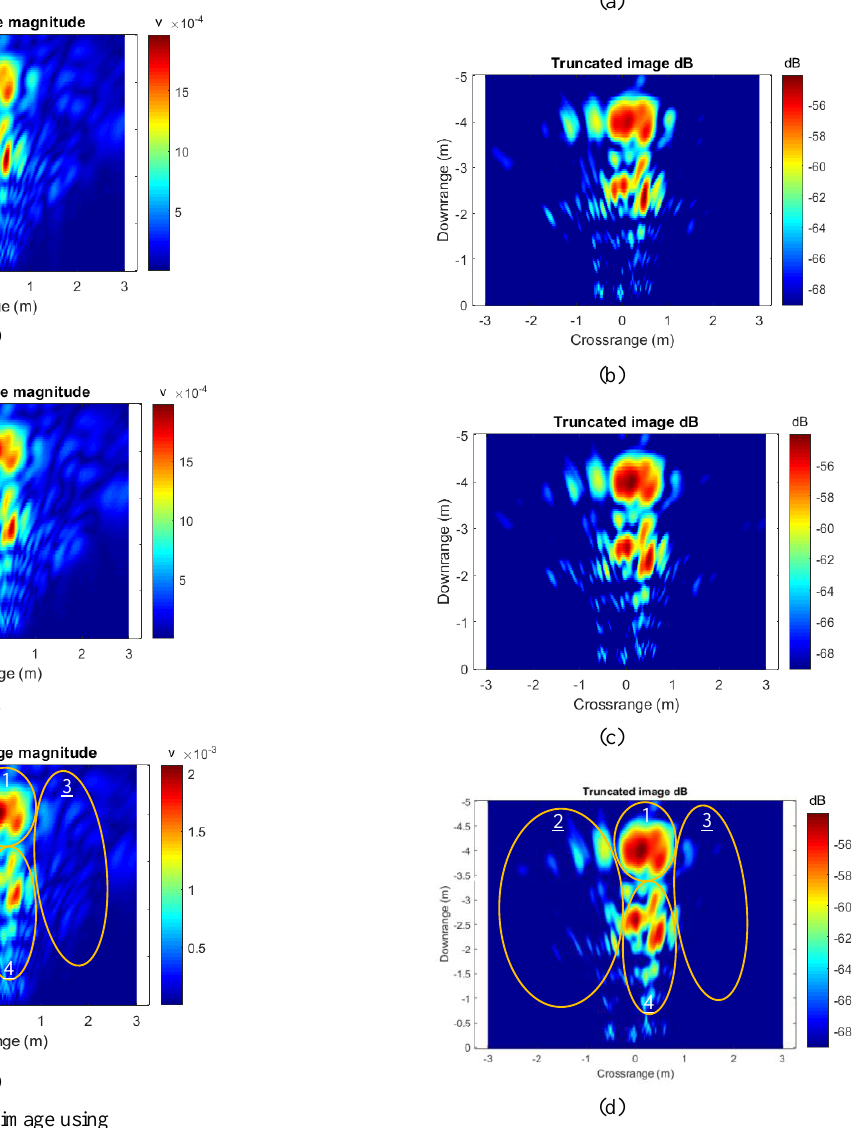
Figure 3. SAR image using (a) 1 pulse (b) 10 integrated pulses (c) 30 integrated pulses (d) 40 integrated pulses in Voltage scale